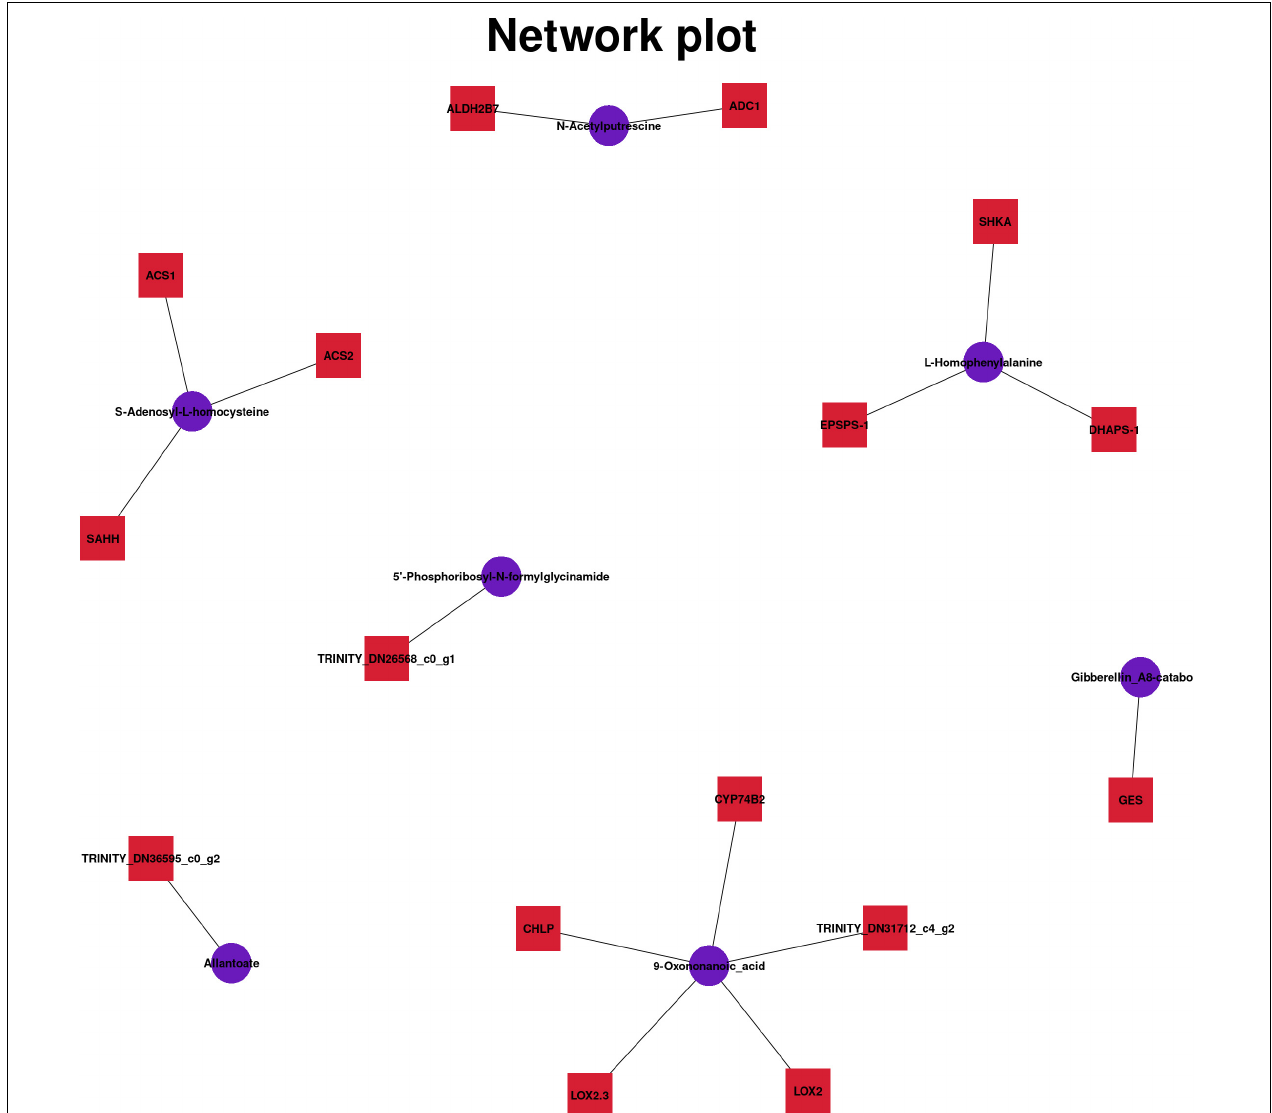
FIGURE 6 | Related genes and metabolites in six